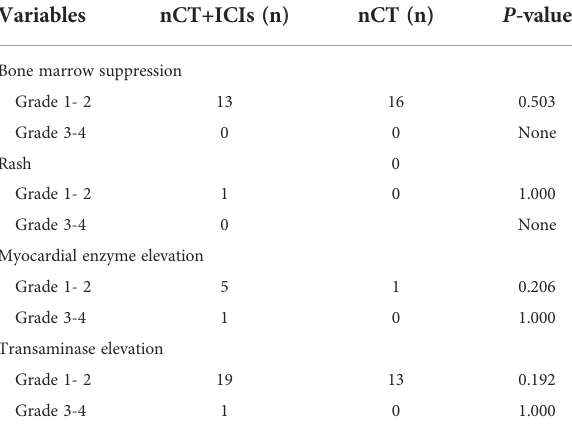
TABLE 4 Complications after neoadjuvant therapy.